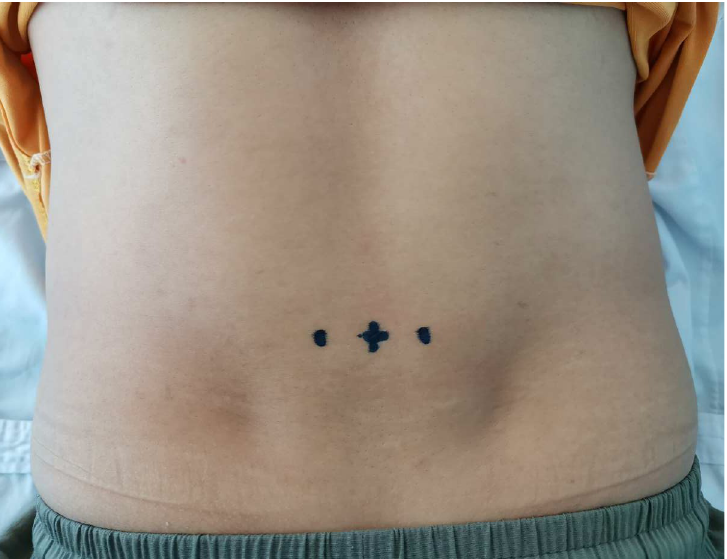
Fig 1. The measurement sites of the erector spinae